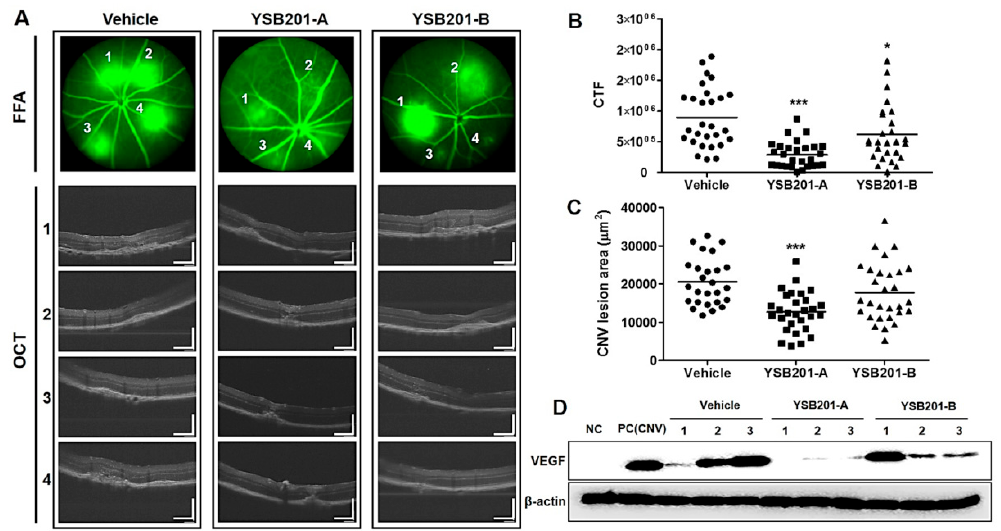
Figure 8. Response examination of the choroidal neovascularization 13 days after CNV induction and oral administration of YSB201. ( A ) Based on representative FFA images of each treatment group, OCT was captured for each CNV lesion (no. 1–4) and displayed with the scale bar (200 µ m). The quantification was performed for the FFA images of each group to obtain ( B ) the fluorescein leakage areas (the corrected total fluorescence; CTF). ( C ) CNV lesion areas were assessed using the ImageJ software based on OCT results. The CTF or CNV lesion areas in the YSB201-A (125 mg / kg) or YSB201-B (250 mg / kg)-treated group were noted as compared to that in the vehicle-treated group. * p < 0.05, ** p < 0.01, *** p < 0.001 by 1-way ANOVA test (significance level = 0.05). ( D ) Western blot analysis was performed for the detection of VEGF expression levels in each treatment group (oral administration of YSB201-A or -B after CNV induction) ( n = 3), as compared with NC (negative control without